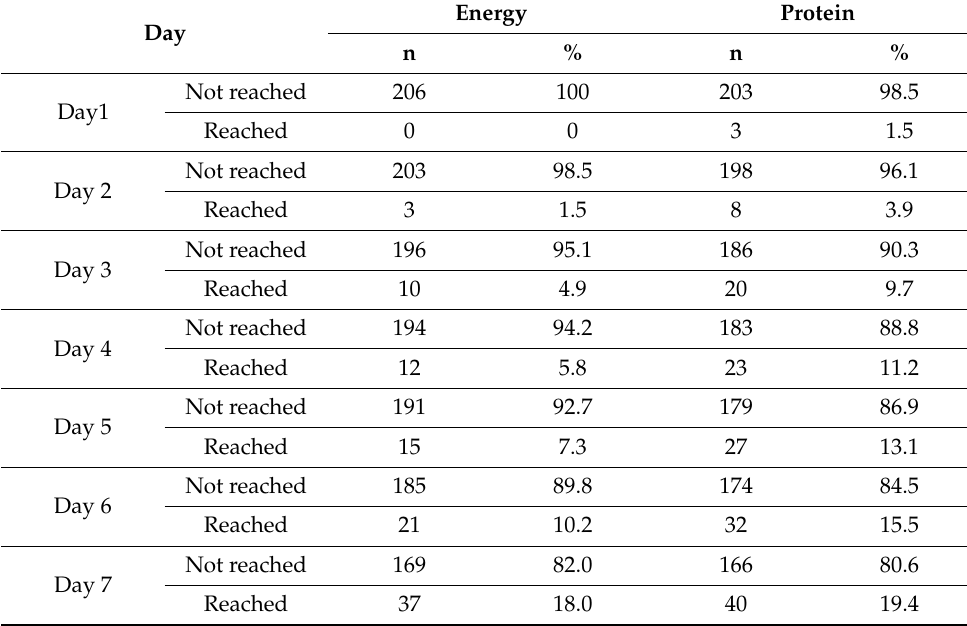
Table 7. Comparison of average postoperative (D1–D7) dietary intake according to European Society for Clinical Nutrition and Metabolism